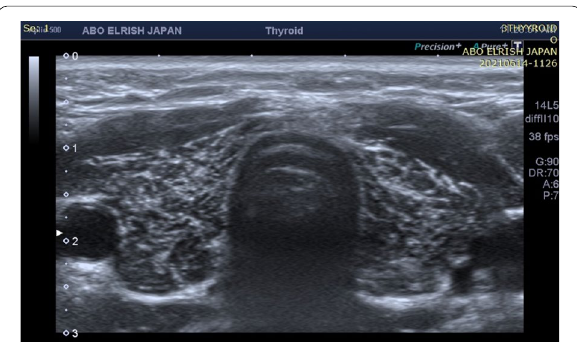
Fig. 1 Thyroid ultra-sound of a 9 years female with history of neck swelling since 4 years with positive TPOAb and TGAb, T4 1.1 and TSH 0.07 diagnosed as Hashimoto’s thyroiditis under medication with tab eltroxin showing heterogeneous texture of both thyroid lobes with multiple scattered hypoechoic micronodules and hyperechoic septations